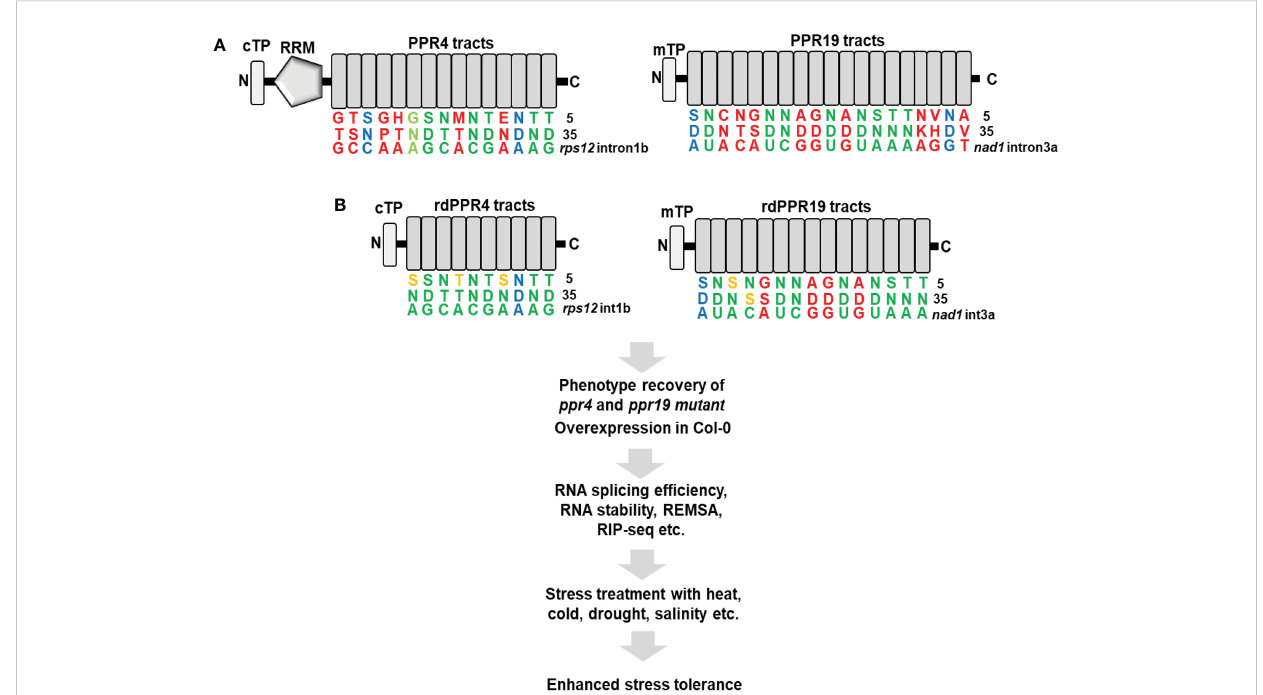
FIGURE 1 A redesign of Arabidopsis PPR4 and PPR19 proteins targeting to native RNA substrates. (A) The combination of the fi fth and thirty- fi fth amino acids on the native PPR4 and PPR19 proteins speci fi cally recognizes target RNA sequences indicated with green colors for perfect matches, light green colors for less perfect matches, blue colors for mismatches, and red colors for no predictable matches. (B) The redesigned Arabidopsis PPR4 and PPR19 proteins with reprogrammed PPR tracts, which is named rdPPR4 tracks and rdPPR19 tracks. The RRM and N-terminal PPR tracts of the PPR4 protein and the C-terminal PPR tracts of the PPR19 protein, which do not participate in target RNA recognition, are eliminated. The PPR-RNA binding codes are modi fi ed for better matches with its cognate target RNA sequences as shown with orange colors. REMSA, RNA electrophoretic mobility shift assay; RIP-seq, RNA immunoprecipitation-sequencing; cTP, chloroplast transit peptide; mTP, mitochondrial transit